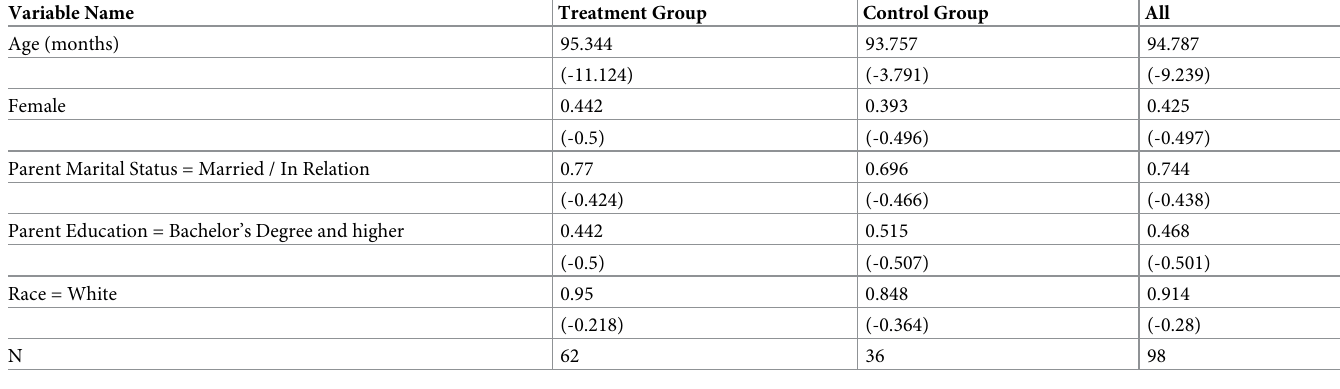
Table 3. Mean/frequency comparison of the pre-treatment base